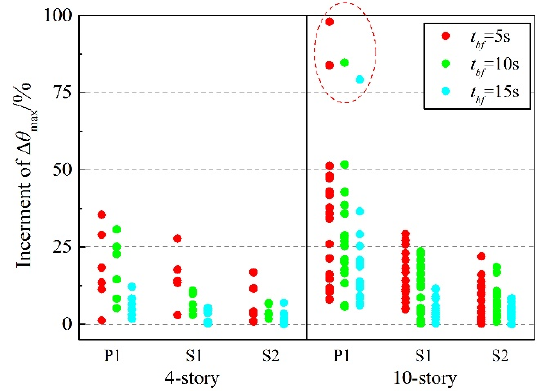
Figure 17. Increment of Δ θ max in adjacent story of failure story.